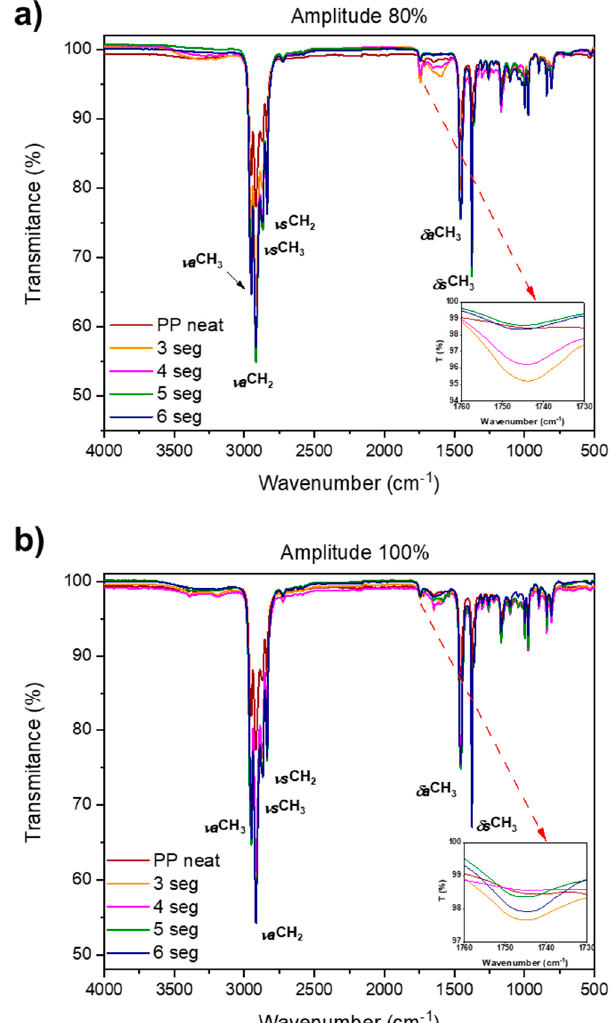
Figure 12. FTIR spectra of specimens fabricated through the UMIM process at different processing times for two selected amplitudes: ( a ) 80%, and ( b ) 100%. The inset graphs demonstrate the oxidation process occurring in the processing carried out at ambient conditions.